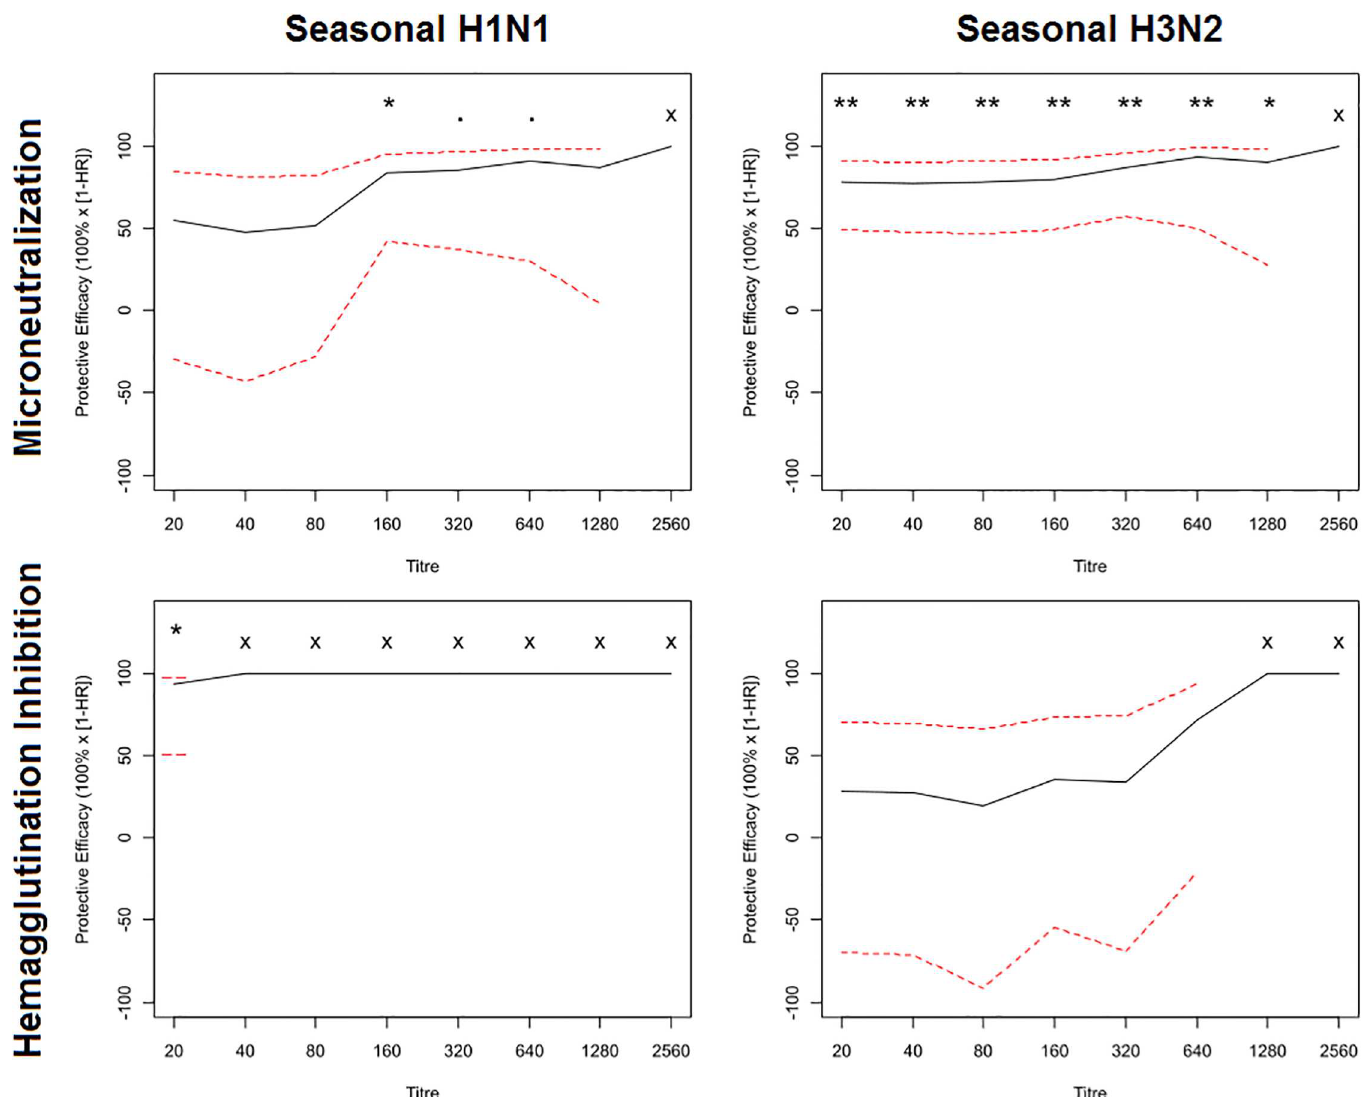
Fig 2. Protective effectiveness of antibody titre cut-offs against seasonal influenza H1N1 and H3N2 is greater when estimated using the microneutralization (MN) assay, as compared to the hemagglutination inhibition (HAI) assay. Protective effectiveness against PCR-confirmed influenzawas compared at different MN and HAI titre cut-offs for seasonalH1N1 (A/Brisbane/59/2007)and H3N2 (A/Brisbane/10/2007). The hazard ratio represents the risk at cut-offs greater than or equal to a given titre, relative to levels less than the cut-off, and was calculated using Cox’s proportional hazards model, adjustingfor donor colony using a robust sandwich estimator. Dotted lines represent the 95% confidence interval and p-values (adjusted using the Benjamini-Hochbergprocedure) were calculated using standard error estimates from the regressionmodel.